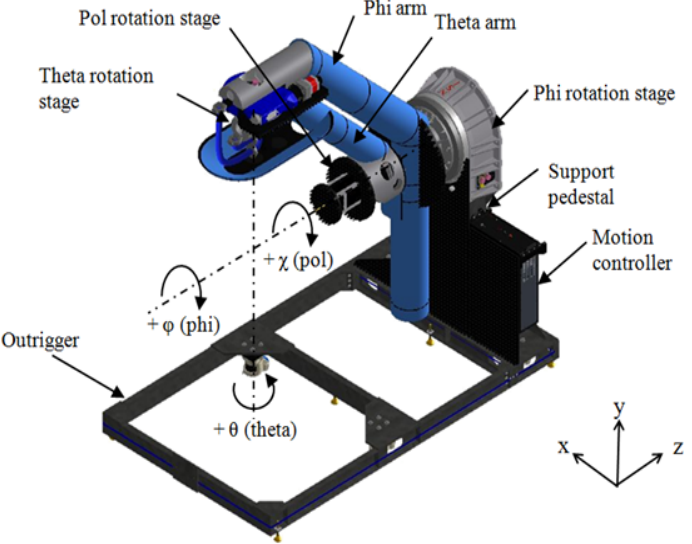
Figure 1. Radar data acquisition setup.